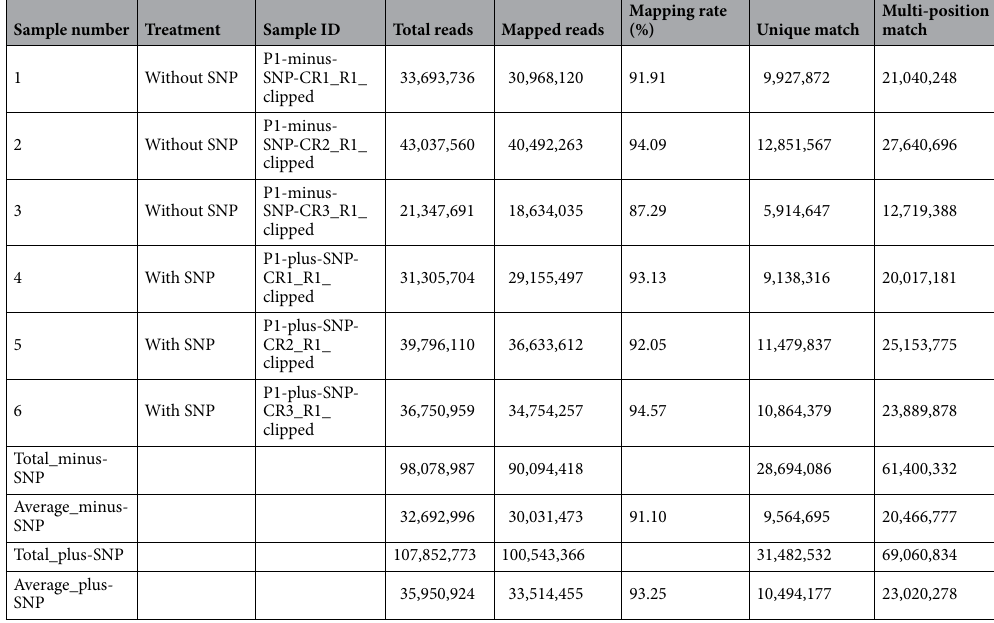
Mapping rate (%) Unique match